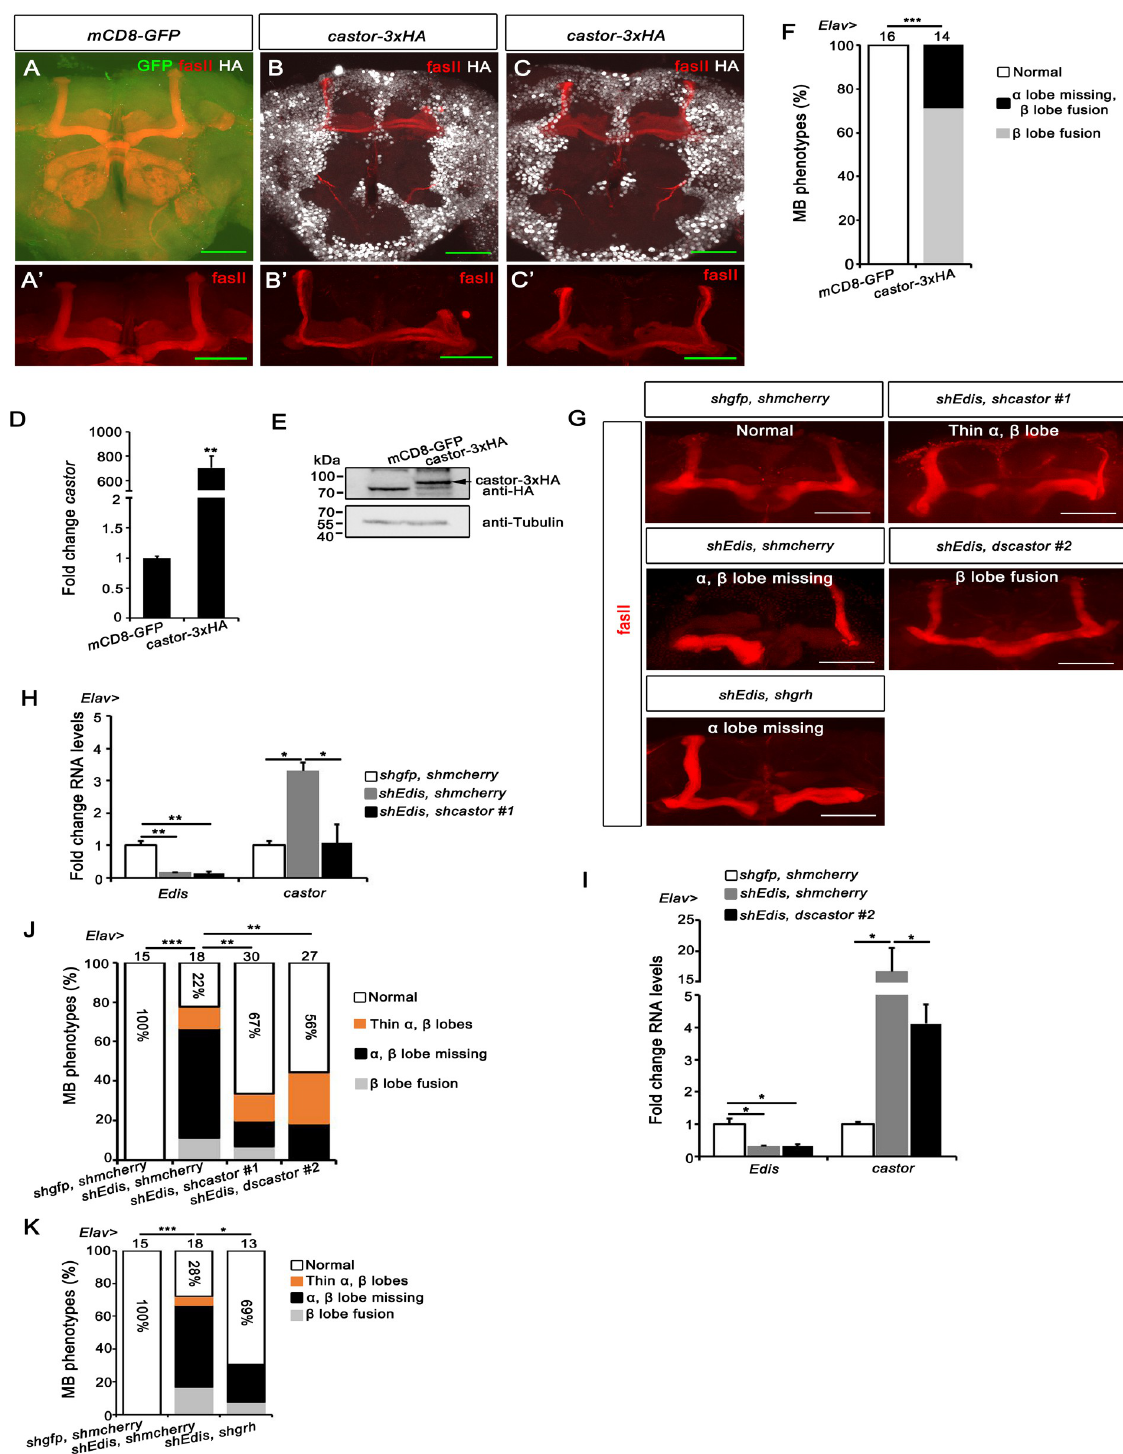
Fig 5. Castor functions downstream of Edis in MB neurodevelopment. ( A - C’ ) Overexpression of castor in neurons led to MB morphology defects. UAS-castor - 3XHA or UAS-mCD8GFP (control) flies were crossed to Elav-Gal4 flies. Brains of progeny of indicated genotypes were stained by anti-HA and anti-FasII antibodies. A’ , B’ and C’ show images of MB area in A , B and C , respectively. The scale bar indicates 50 μ m. ( D-E ) Levels of castor mRNA and castor-HA protein were measured by real-time PCR ( D ) and immunoblot ( E ), respectively and compared to control (n = 3). ( F ) MB morphology phenotypes of indicated genotypes in A - C’ were quantified. Chi-squared test was